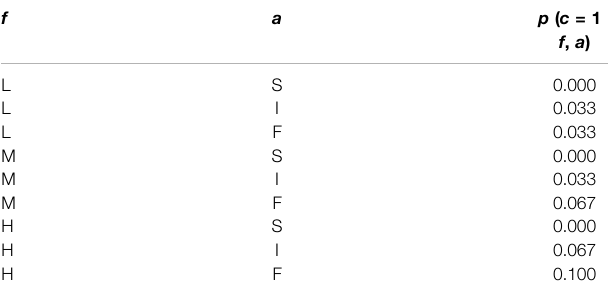
TABLE 3 | Main elements of the POMDP model for the collision avoidance problem. Collision model p ( c | f , a ): collision probability given segment dif fi culty and